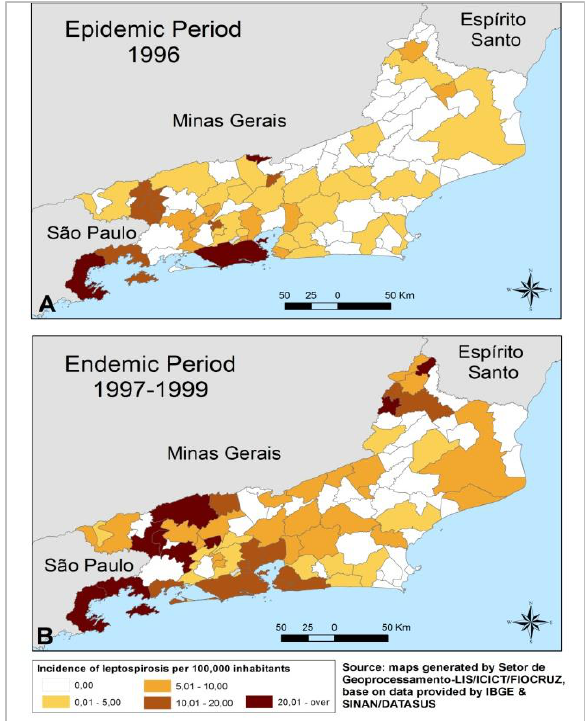
Figure 1. Leptospirosis incidence rates in the municipalities of Rio de Janeiro state during epidemic ( A ) and ( B ) endemic periods, respectively.